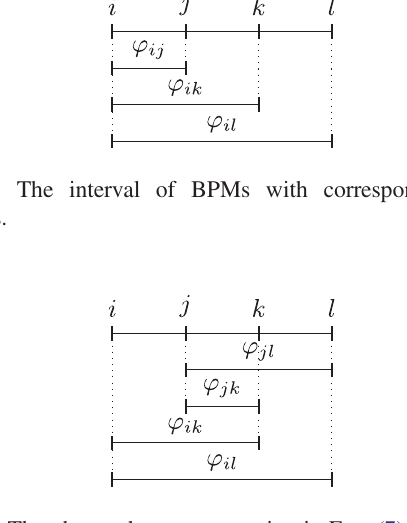
FIG. 2. The phase advances appearing in Eqs. (7) and (8). The phase advances φ ij and φ kl do not appear in the final form of the local